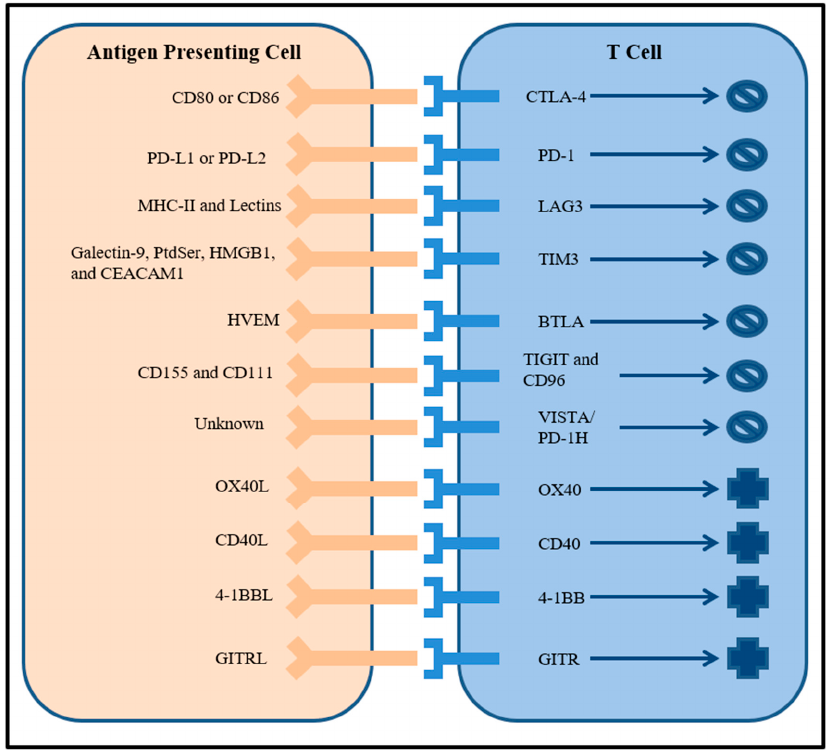
Figure 1. Cartoon of well characterized inhibitory and stimulatory immune checkpoint receptors on T cells and their ligands expressed by antigen presenting cells.